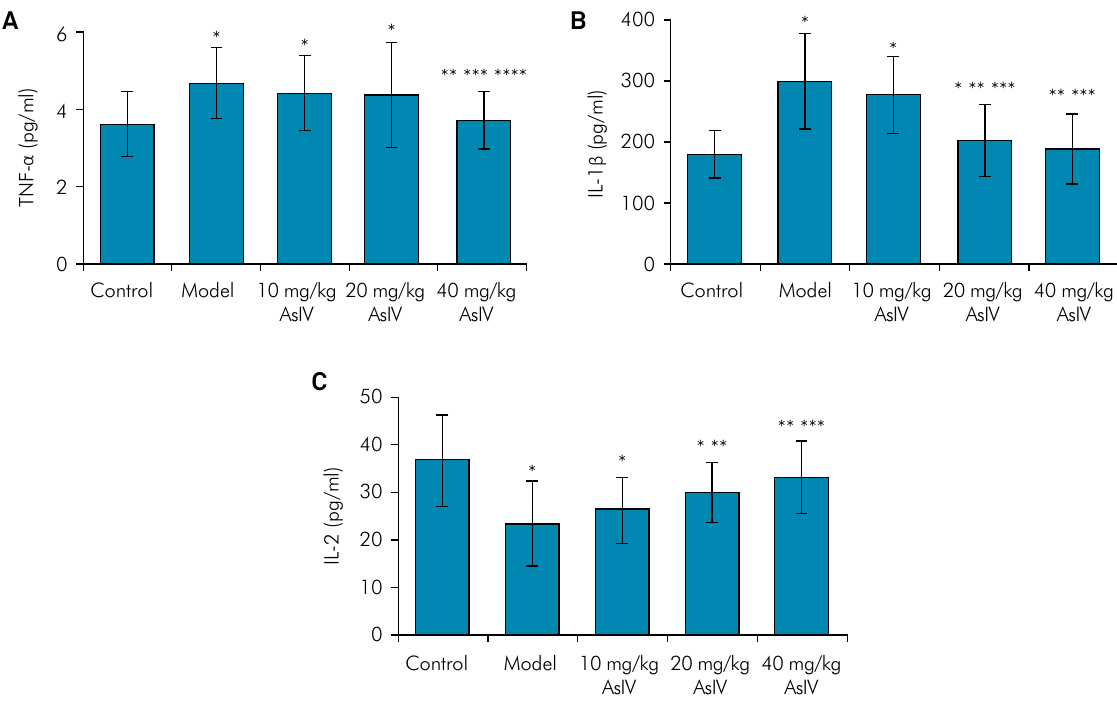
Figure 2. Serum TNF- α , IL-1 β and IL-2 levels in different groups after treatment. A: TNF- α ; B: IL-1 β ; and C: IL-2. * p < 0.05 compared with the control group; ** p < 0.05 compared with the model group; *** p < 0.05 compared with the 10 mg/kg AsIV group; and **** p < 0.05 compared with the 20 mg/kg AsIV group. AsIV, astragaloside IV; TNF- α , tumor necrosis factor- α ; IL-1 β , interleukin-1 β ; and IL-2,